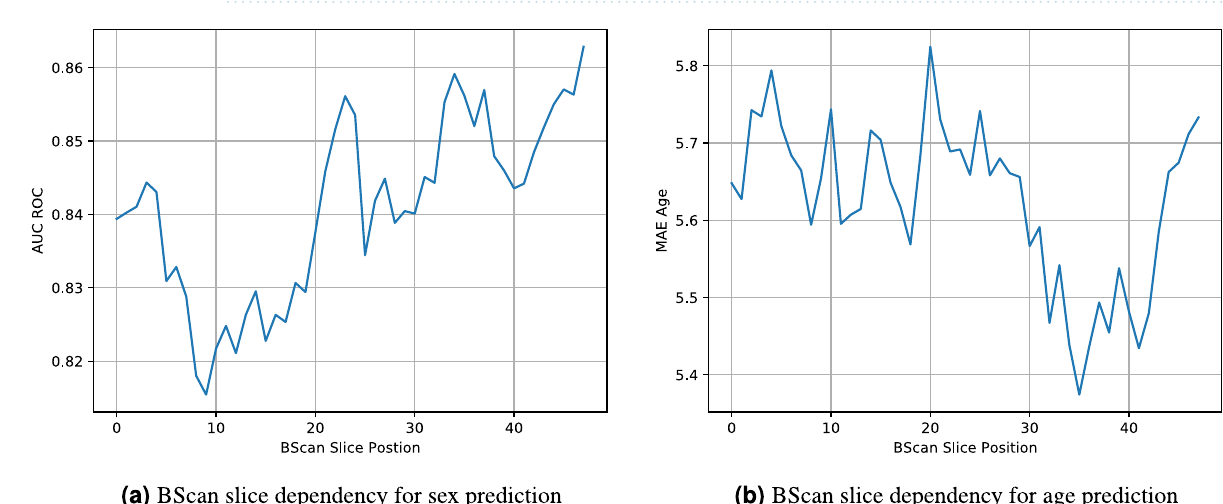
Figure 5. Age dependant results for sex and age binned into bins of 10 years. Independent of image modalitiy sex prediction is more accurate among age groups of ≤ 60 years. Above the age of 60 the performance declines. Confidence intervals are provided for the right plot.